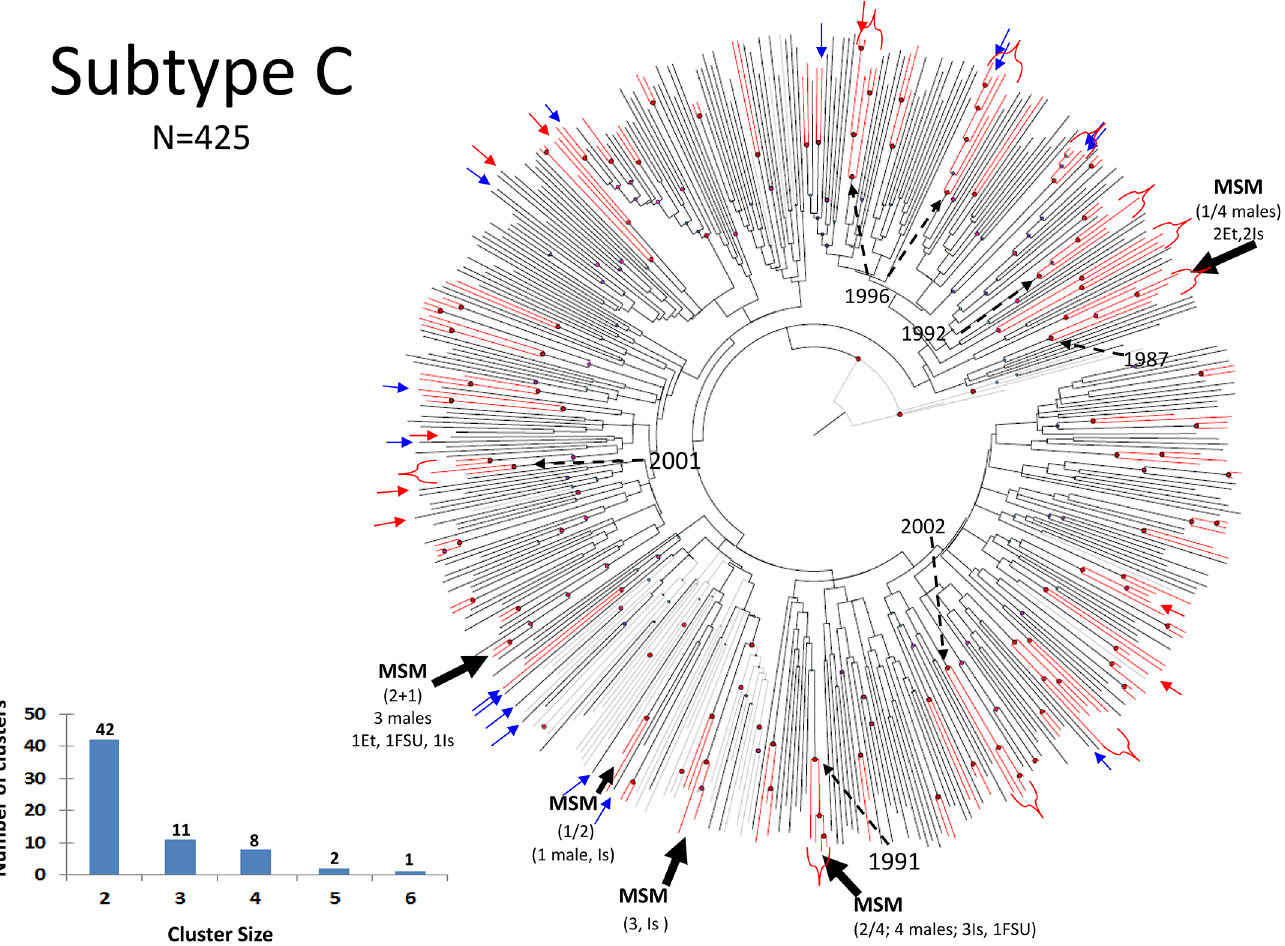
Fig 2. Bayesian evolutionary analysis sampling trees (BEAST) of subtype C. Sequences from patients infected with subtype C viruses were subjected to Monte-Carlo Markov Chain (MCMC) analyses using BEAST to construct phylogenies and investigate ancestral relationships. 47 reference subtype C sequences (http://www.hiv.lanl.gov/) were included. The MCMC length (burn in 10%) was of 400 – 600 million states to achieve posterior effective sample size (ESS) > 200 as described [26]. Red lines represent branches with posterior probability of recent common ancestor (cid:1) 0.95. Red-circled nodes represent posterior probability (cid:1) 0.95. The largest clusters are marked. Insets describe the number and size of clusters. Israeli-born and FSU-born infected with subtype C are marked with thin blue and red arrows, respectively. Dashed arrows indicate calculated year of selected nodes. FSU, Former Soviet Union; Hetero, heterosexuals; IVDU, intravenous drug users; MSM, men who have sex with men.